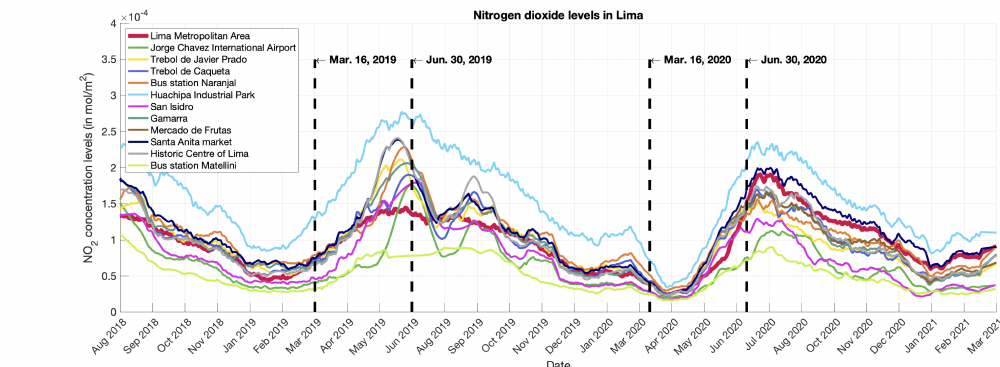
Figure 5. Historic nitrogen dioxide pollution levels in Lima for the twelve selected zones in Lima, where there is no sensor from SENAMHI (see Section 2.2) from August 2018 to March 2021.